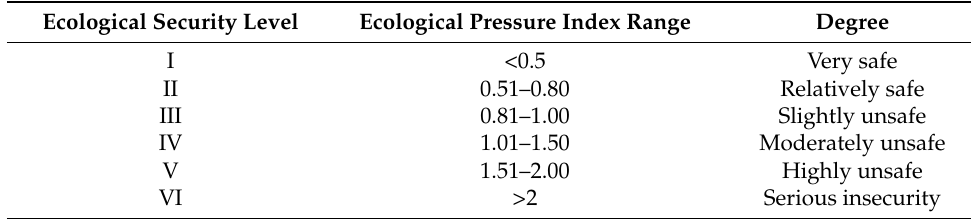
Table 1. Classification Standard of ecological pressure index. Ecological Security